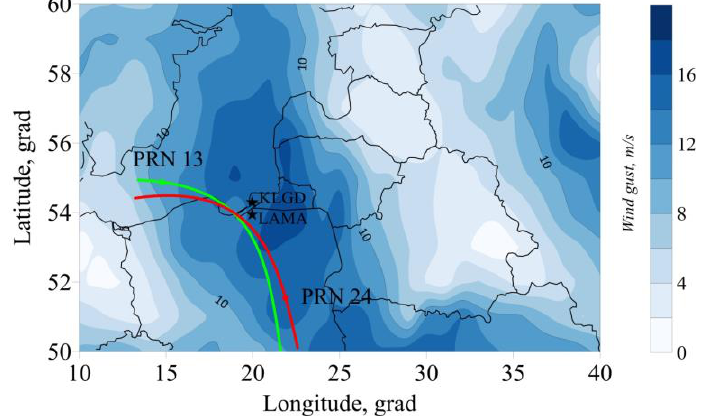
Figure 2. Spatial distribution of wind speed according to the ERA5 reanalysis data over the meteorological storm area at 15:00 UTC on 1 April 2016. The green and red lines correspond to the projections of the trajectories of the PRN 13 and PRN 24 satellites, respectively. Arrows indicate the direction of the satellite movement.